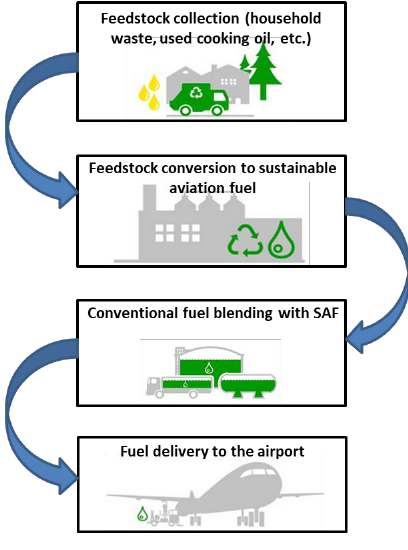
Fig. 1. Sustainable fuel production process